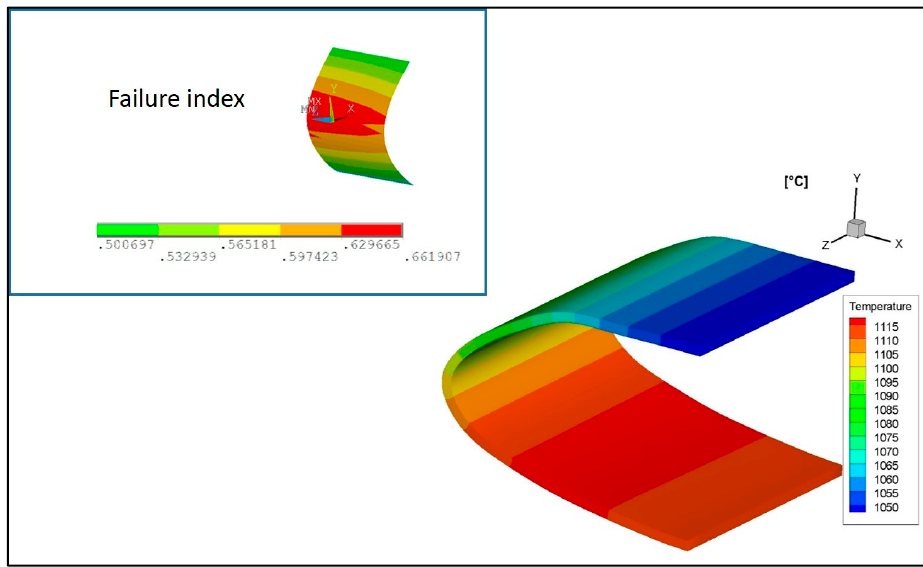
Figure 11. Temperature contour plot at 1200 second – Local model B – BC taken from the global coarse shell model – Temperatures are expressed in °C.